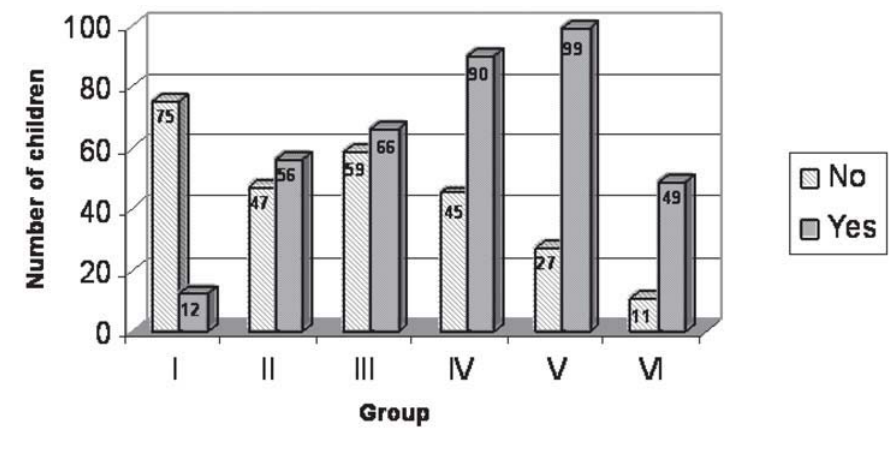
FIGURE 2- Distribution of the children who had already or had not yet gone to the dentist, according to their age